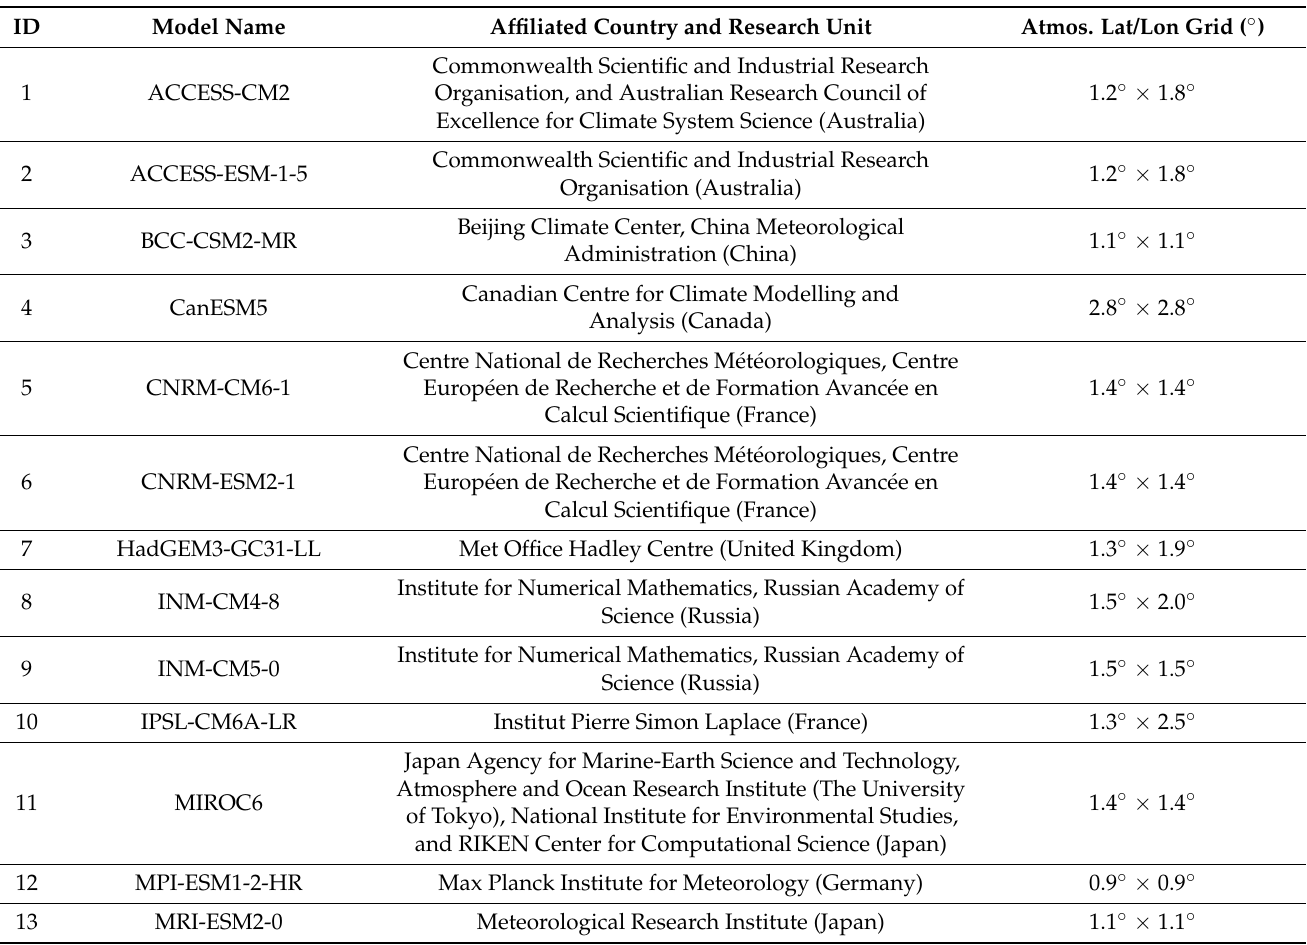
Table 1. General inflormaiton of CMIP6 models used in this